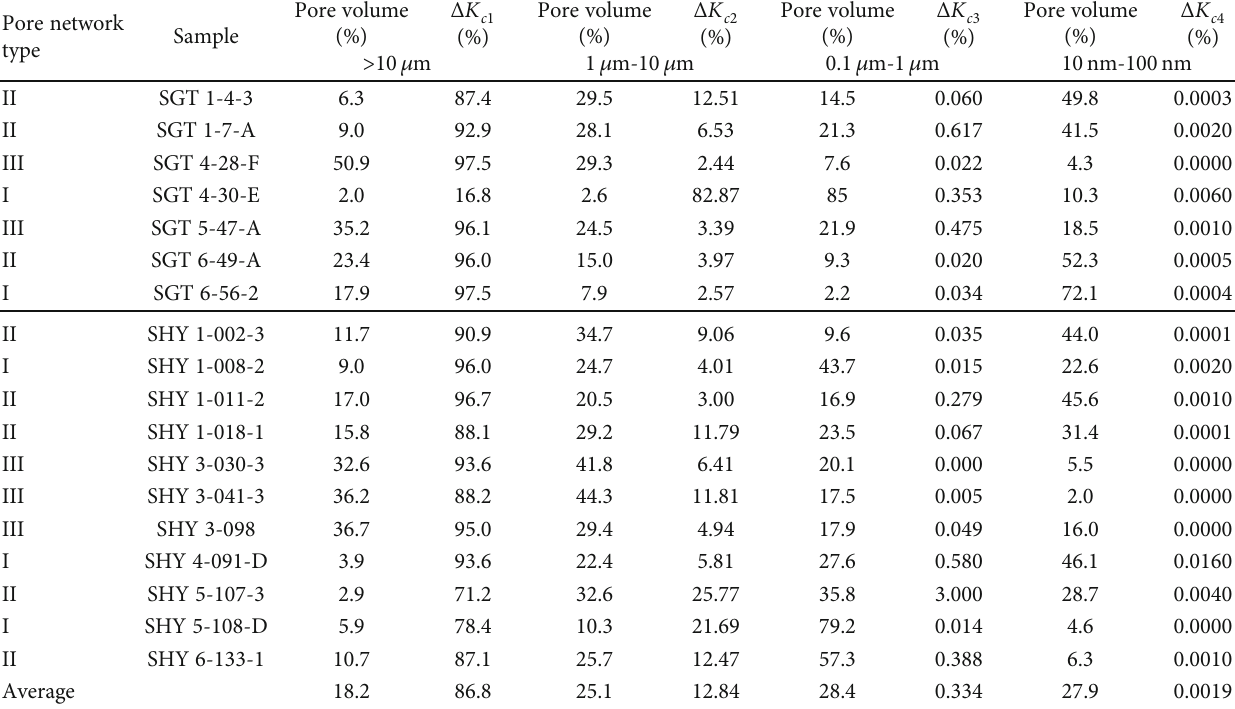
Table 2: Total pore volume and permeability contribution of the four pore networks to each sample. Pore